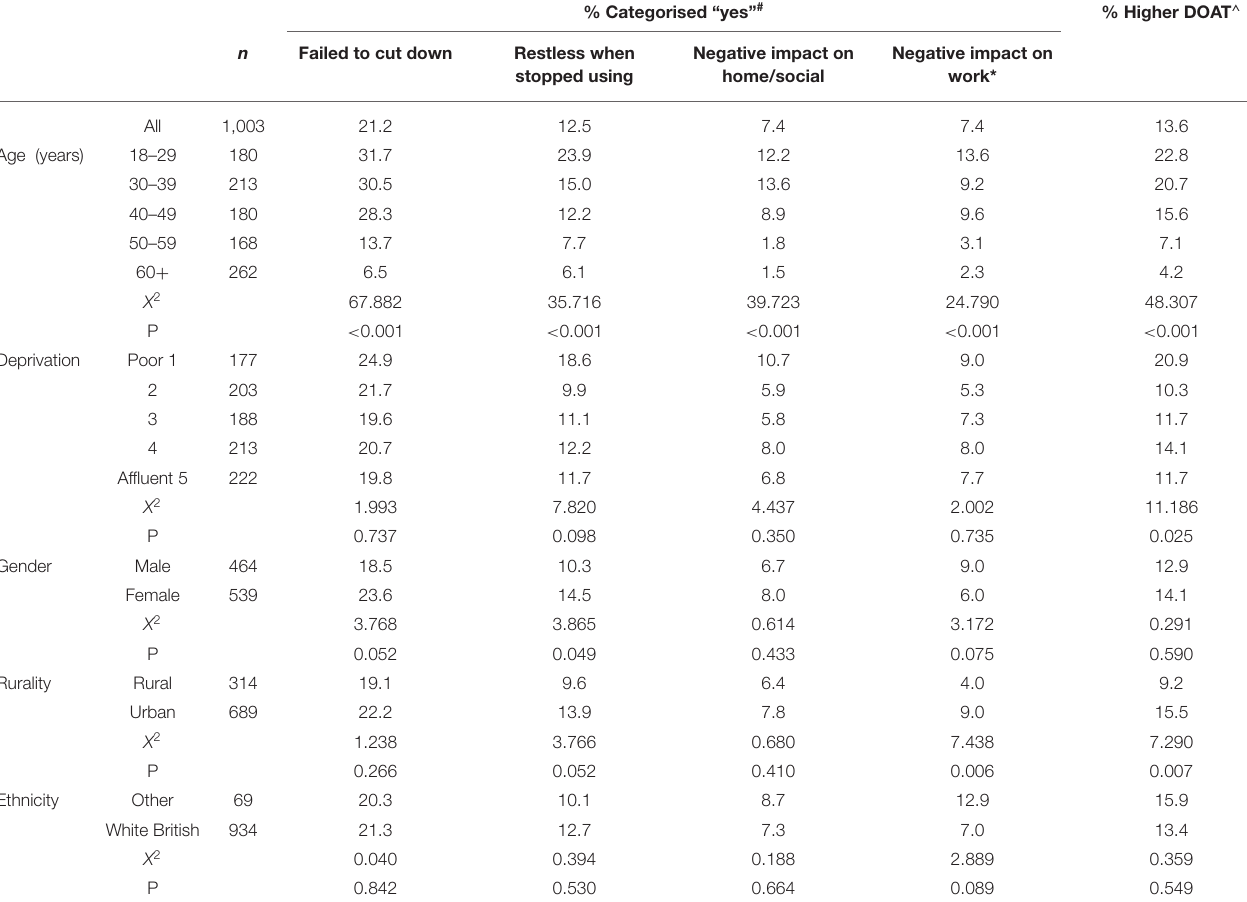
TABLE 1 | Demographic distribution of Digital Overuse and Addiction Traits (DOAT). % Categorised “yes” # % Higher DOAT ∧ n Failed to cut down Restless when Negative impact on Negative impact on stopped using home/social